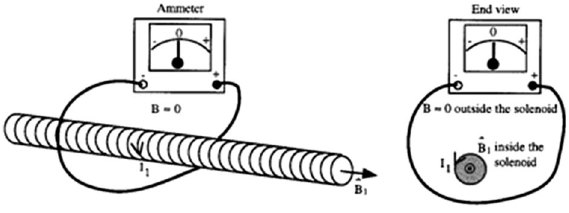
FIG. 3. Experimental setup in the laboratory of activity